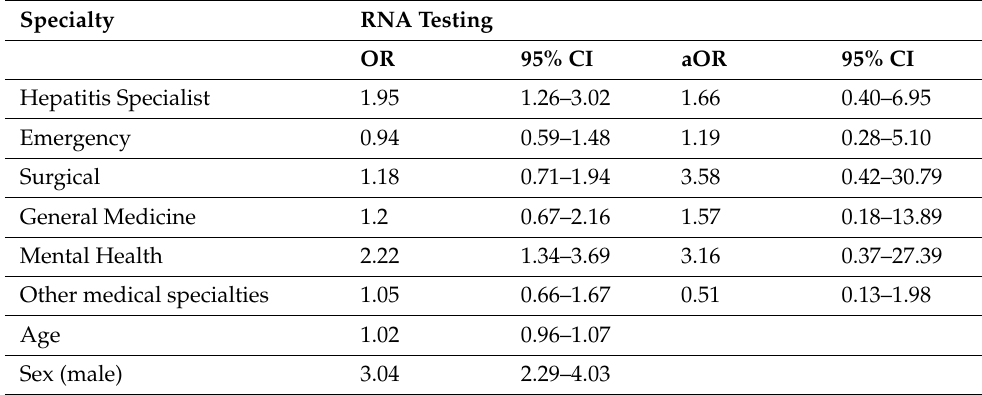
Table 3. Odds ratios for patients having RNA testing by